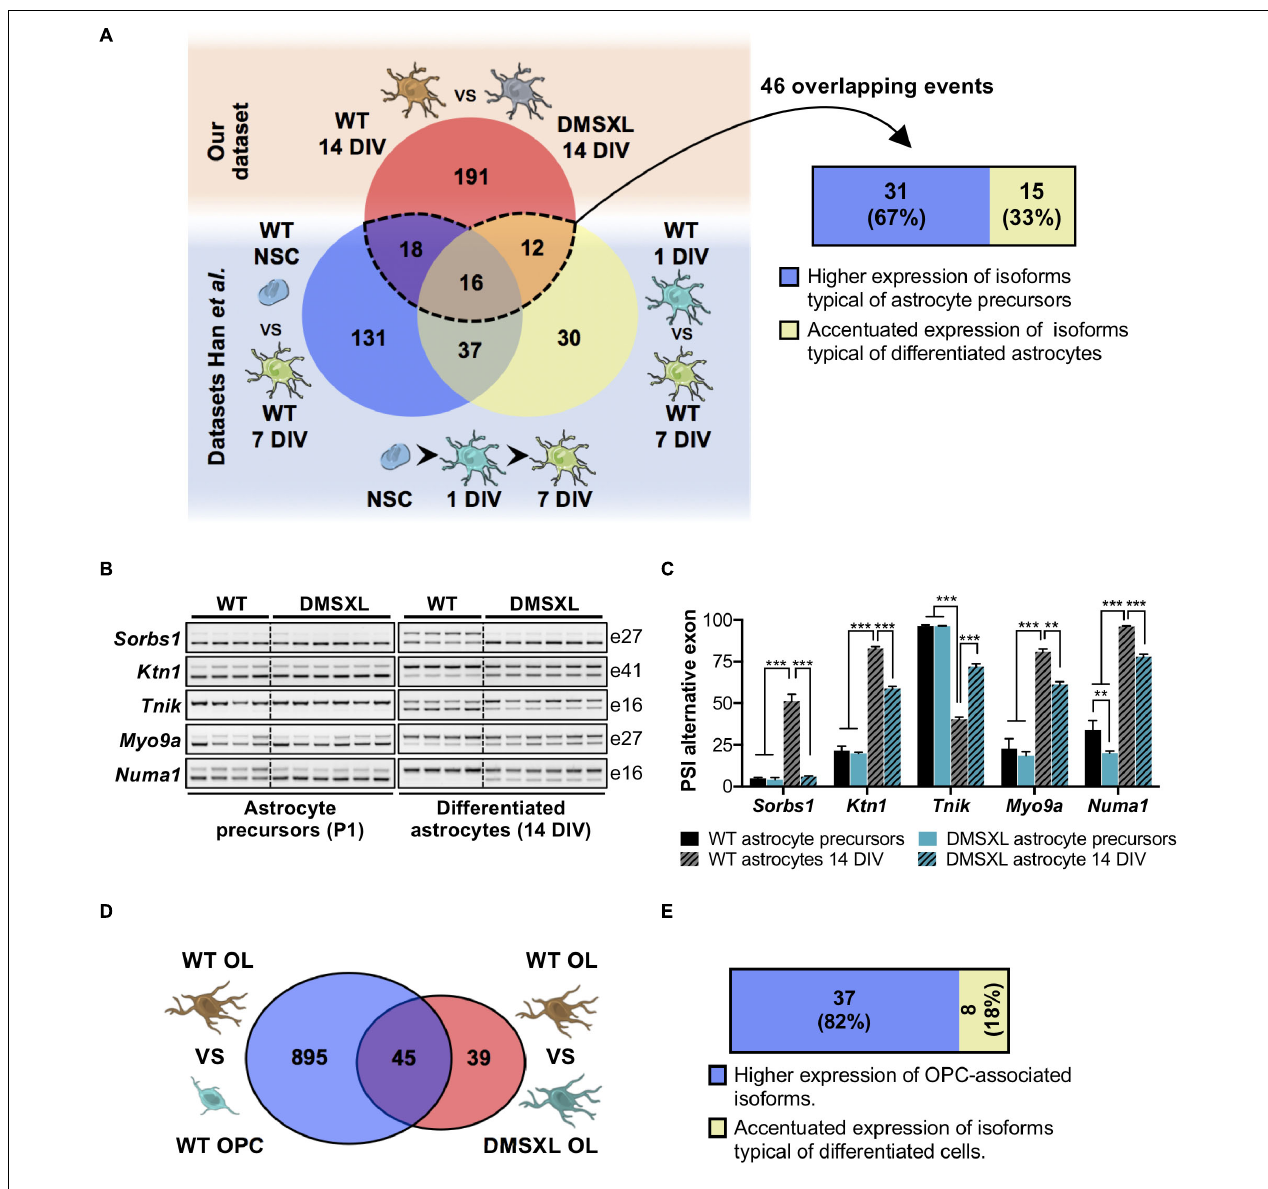
FIGURE 6 | Analysis of DMSXL splicing profiles during glia cell differentiation. (A) Significant overlap of DMSXL astrocytes splicing defects with changes occurring during WT astroglia differentiation (representation factor: 23.4, p < 1.7E-49). A significant fraction of overlapping splicing changes resulted in the upregulation of RNA isoforms typical of less differentiated astrocytes (Fisher’s exact test, p = 0.023). (B) RT-PCR analysis of alternative cassette exons with impaired or partial splicing switch during astrocyte differentiation, from isolated precursors (P1) to astrocytes differentiated in culture (14 DIV). Alternative exon numbers are indicated on the right. (C) PSI of alternative exons in astrocyte precursor and astrocytes differentiated in culture (14 DIV), collected from DMSXL and WT mice (** p < 0.01; *** p < 0.001; one-way ANOVA; n = 4 WT, n = 6 DMSXL, independent cultures). (D) Overlap of splicing variations concomitant to WT oligodendroglia transition, with the dysregulated splicing events in DMSXL OL (representation factor: 16.5, p < 1.4E-44). (E) Significant overrepresentation of splicing changes that increase the expression of OPC-associated RNA isoforms in DMSXL OL (Fisher’s exact test, p = 0.003). Drawings of brain cells from Servier Medical Art, licensed under